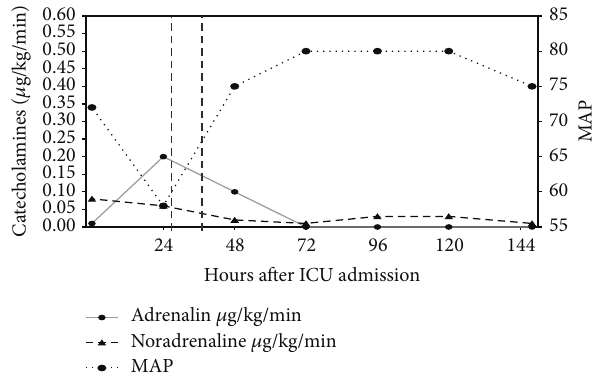
Figure 1: Time course of adrenaline and noradrenaline demand ( 𝜇 g/kg/min) in relation to the physostigmine application (high- lighted with vertical lines). Resulting mean arterial blood pressure (MAP) is presented with the dashed line.